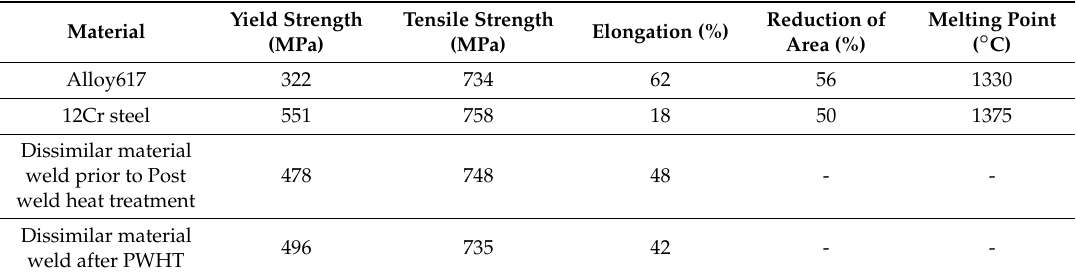
Table 2. Mechanical properties of Alloy617, 12Cr steel, and dissimilar material weld (reproduced from [12], with permission from World Scientific,